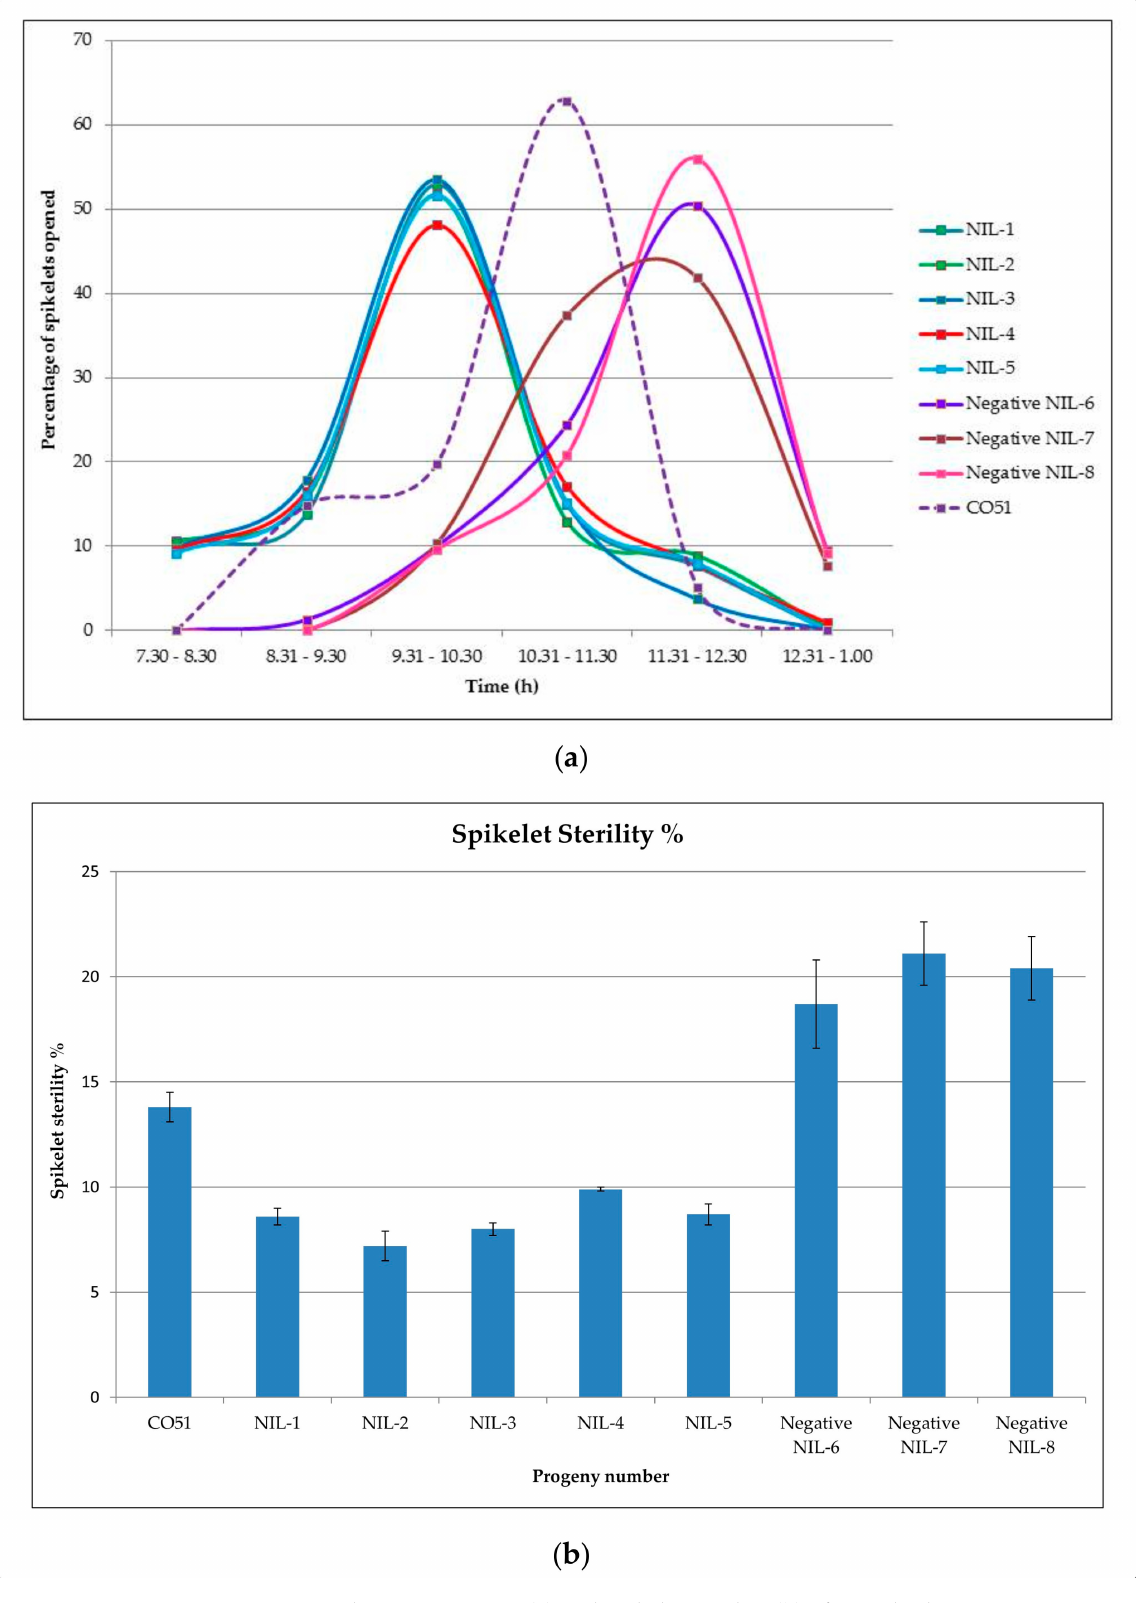
Figure 6. Flowering pattern ( a ) and spikelet sterility ( b ) of NILs harboring qEMF3 in CO 51 back- ground during Kharif